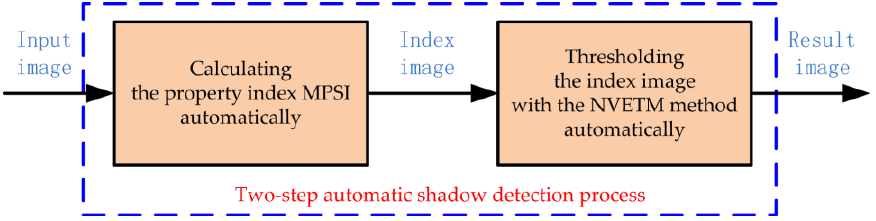
Figure 3. Flow chart of the proposed mixed property-based shadow detection approach.